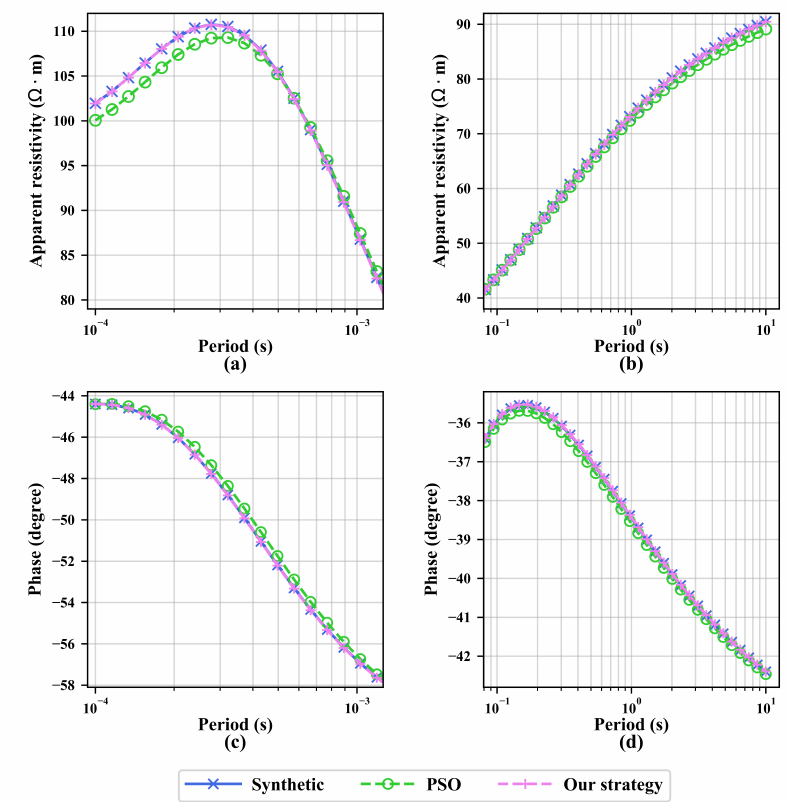
Figure 4. Comparison of the MT response in special frequency bands for the three-layer model. ( a , b ) represent apparent resistivity curves, and ( c , d ) represent phase curves. The blue lines represent the supposed MT responses. The green lines represent the MT responses predicted by traditional PSO. The purple lines represent the MT responses predicted by our strategy.